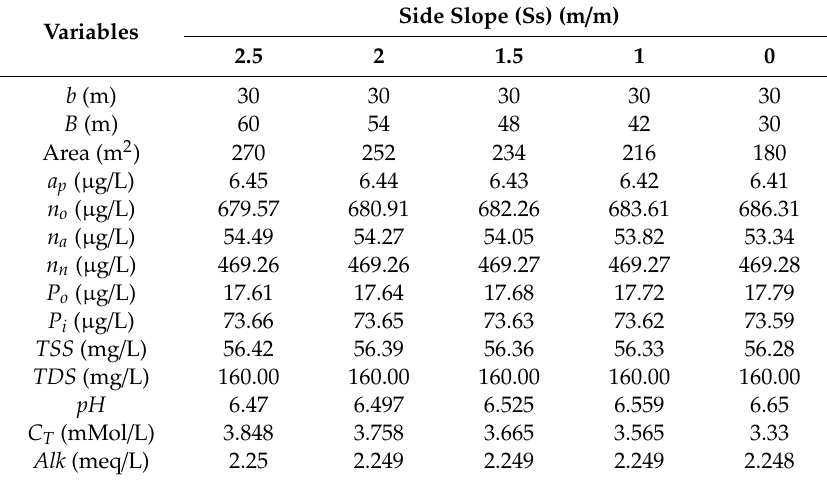
Table 12. E ff ect of side slopes ( Ss ) on di ff erent water quality